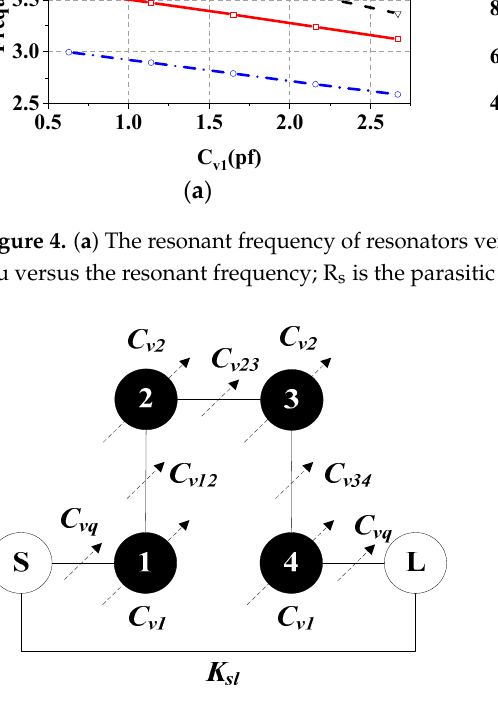
Figure 4. ( a ) The resonant frequency of resonators versus C v1 for different R 4 and L 15 . ( b ) Simulated Qu versus the resonant frequency; R s is the parasitic resistance of C v1 .